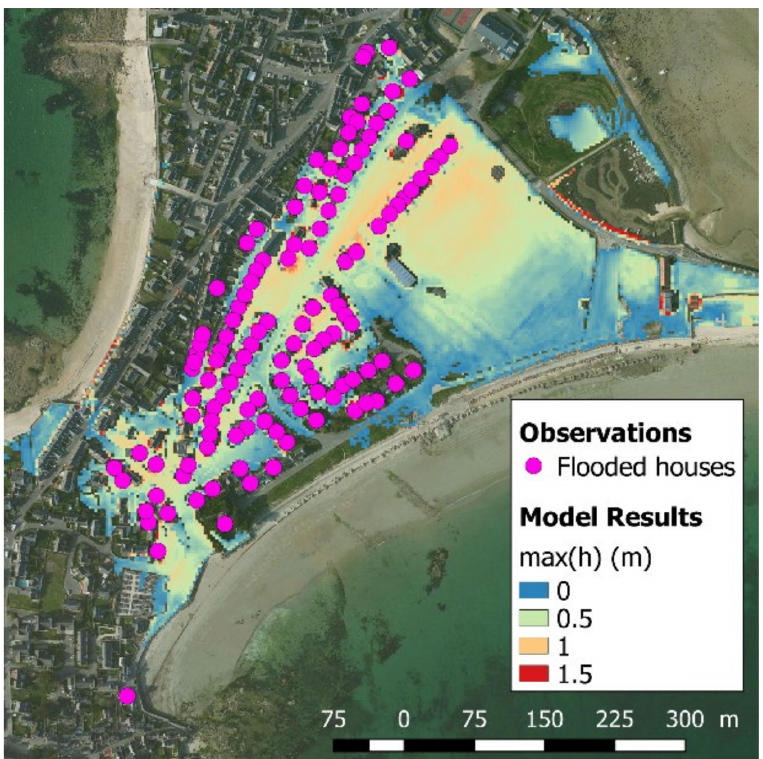
Figure A1. Model validation: maximal simulated water depth and observed flooded houses during the Johanna event. Source: